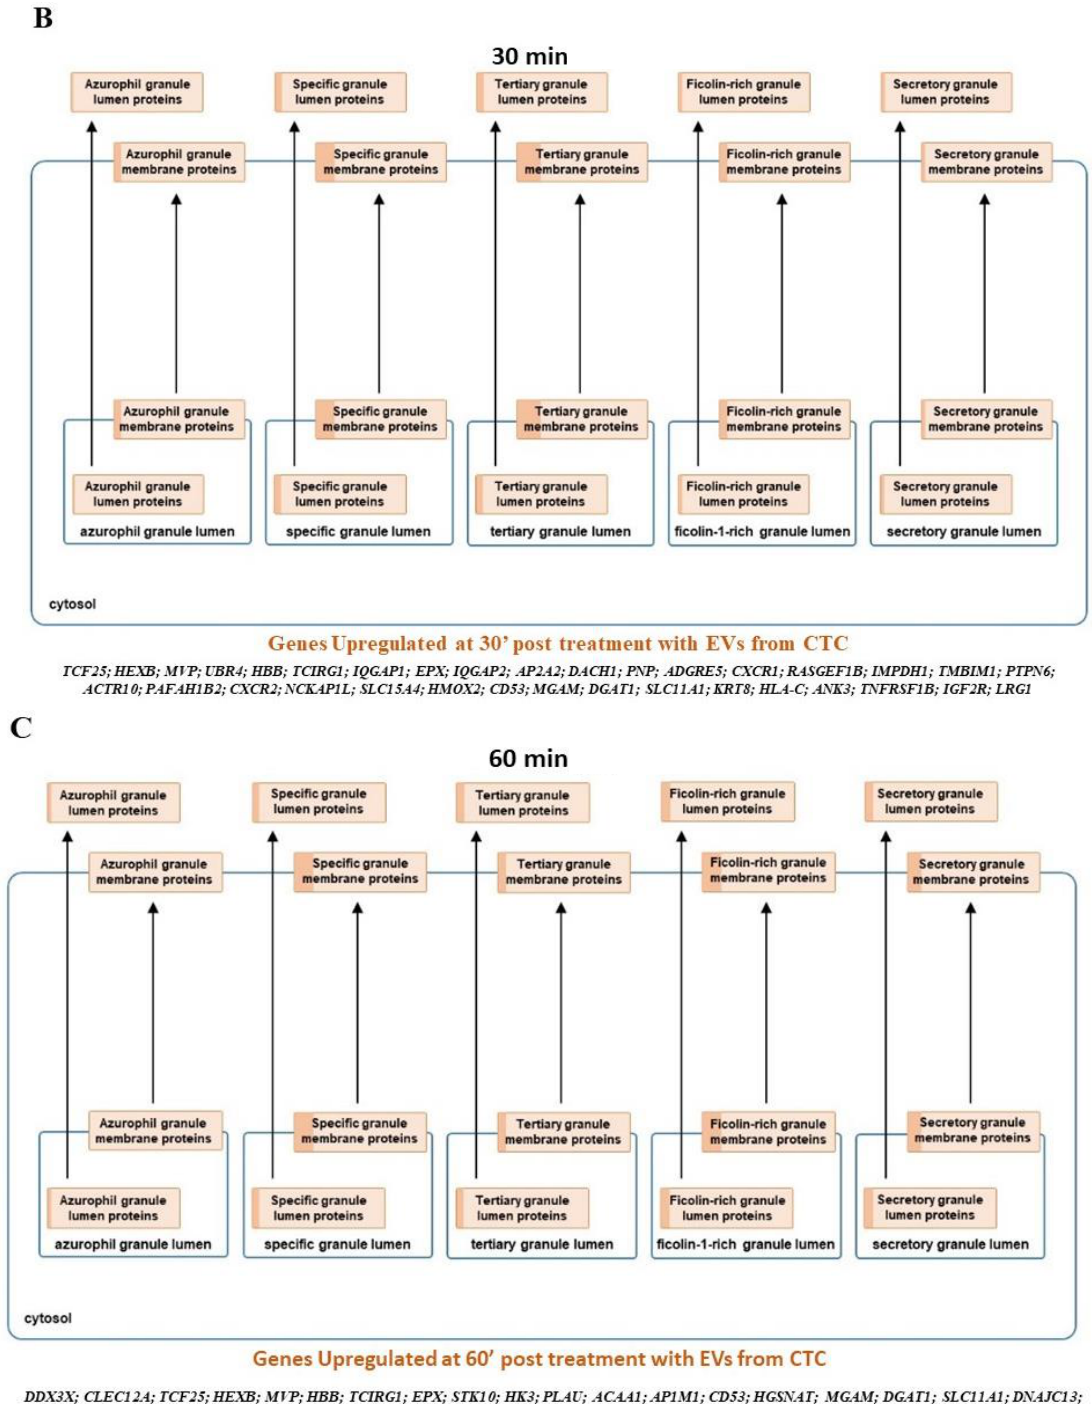
Figure 4. Summary of genes upregulated on exposure to EVs from CM61 that form part of the neutrophil degranulation pathway. The shading in the cellular component indicates the enrichment of number of genes in the said component with more of the granule being shaded indicative of more genes upregulated in that particular component. ( A ) Global change of proteins across all granular compartments are observed at 10 min There is no specific distribution of proteins across one of the cellular components and is a global change of all proteins at this time point; ( B ) 30 min, there is a complete reduction of proteins that constitute the azurophil and secretory granule lumens, while at ( C) 60 min, the azurophil granule proteins are still downregulated while there is a slight increase in proteins that constitute the secretory granule lumen. The levels of specific, tertiary and ficolin1 rich granules do not show major changes between 30 min and 60 min.